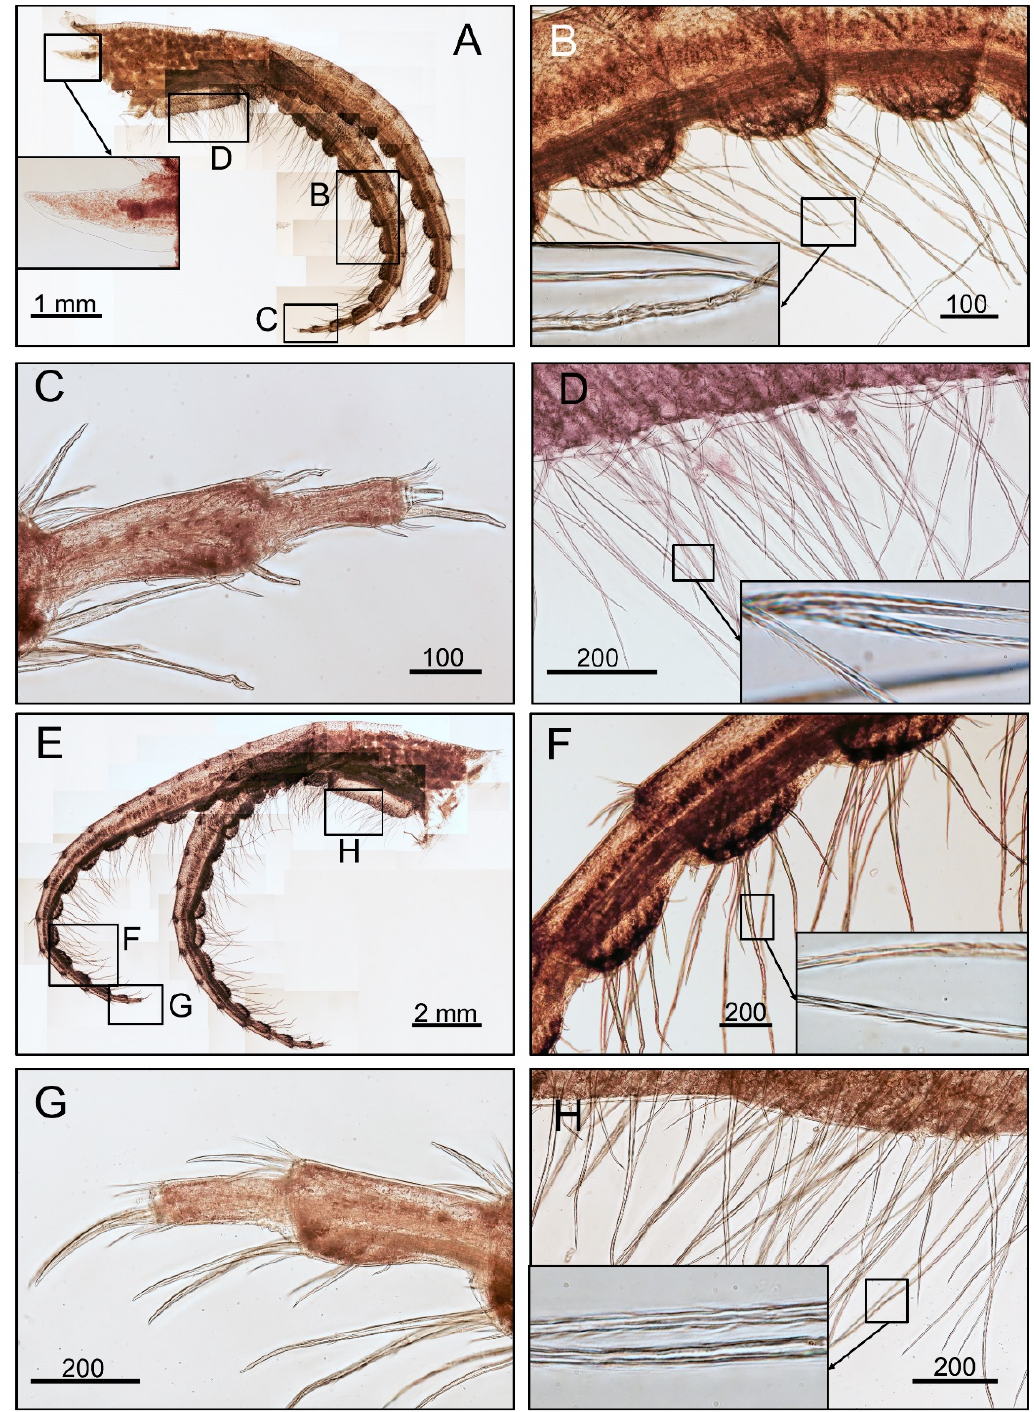
Figure 8. Conchoderma hunteri. ( A ) Cirrus III, note single filamentary appendage at base. ( B ) Intermediate segments of posterior ramus, showing serrulate setae. ( C ) Distal segment of posterior ramus. ( D ) Magnified segment of anterior ramus of cirrus III, showing serrulate setae. ( E ) Cirrus IV. ( F ) Serrulate-type setae at cirrus IV. ( G ) Distal end of posterior ramus of cirrus IV, showing short robust simple setae. ( H ) Intermediate segment of cirrus IV, showing serrulate setae. Scale bars in μ m.